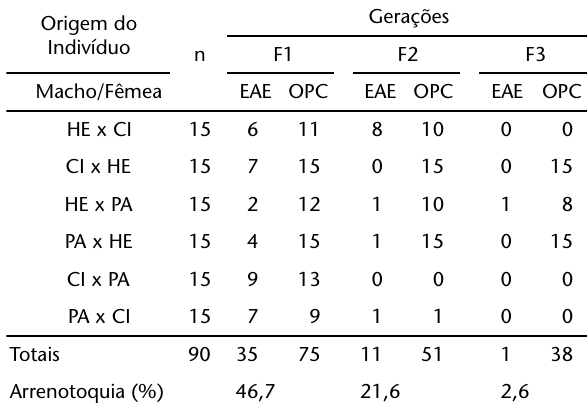
Tabela X. Ocorrência de prole nos cruzamentos (OPC) e número total e porcentagem de eventos arrenótocos exclusivos (EAE) em três gerações consecutivas de intercruzamentos de indivíduos de E . banksi oriundos dos hospedeiros H . brasiliensis (HE). C .